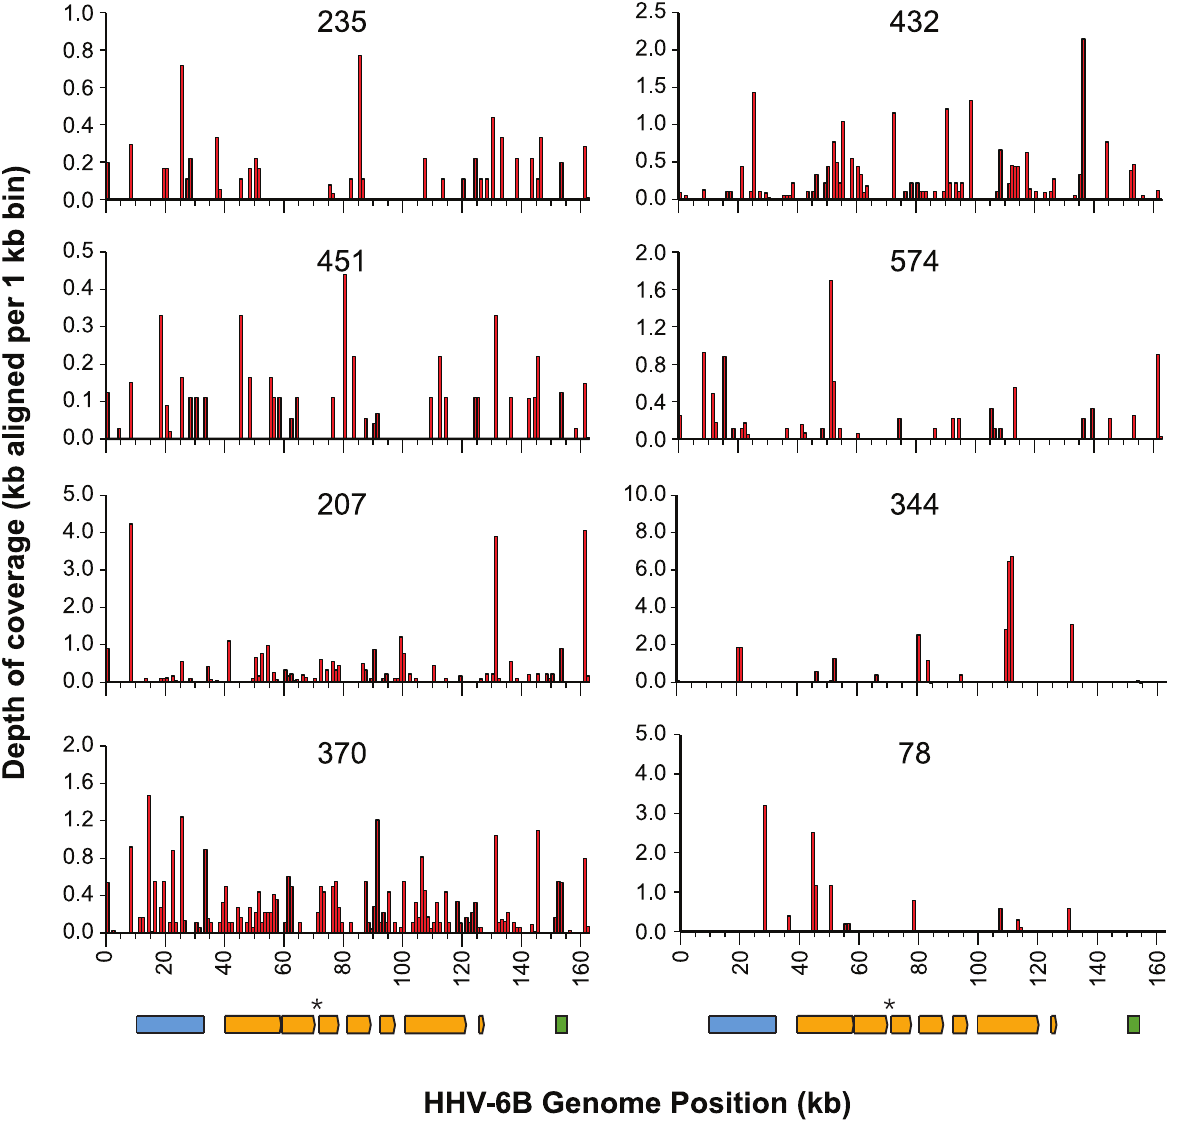
Figure 2. HHV-6B genome coverage in positive samples. Histograms of HHV-6B genome coverage generated by aligning reads with minimum 90% identity over the total read length to the genome. The depth of sequence coverage was calculated as the total Kb of aligned sequence per 1 Kb bin over the HHV-6B reference genome. Genome track representation adapted from Dominguez et al [65]. The blue box represents conserved genes across the betaherpesvirus subfamily, the orange boxes represent core genes across the herpesvirus family, the green box represents the late structural genes (gp82-105), and the asterisk denotes the origin of lytic gene replication. Inset text for each histogram is the sample code. Coverage is shown for samples with greater than 80 HHV-6